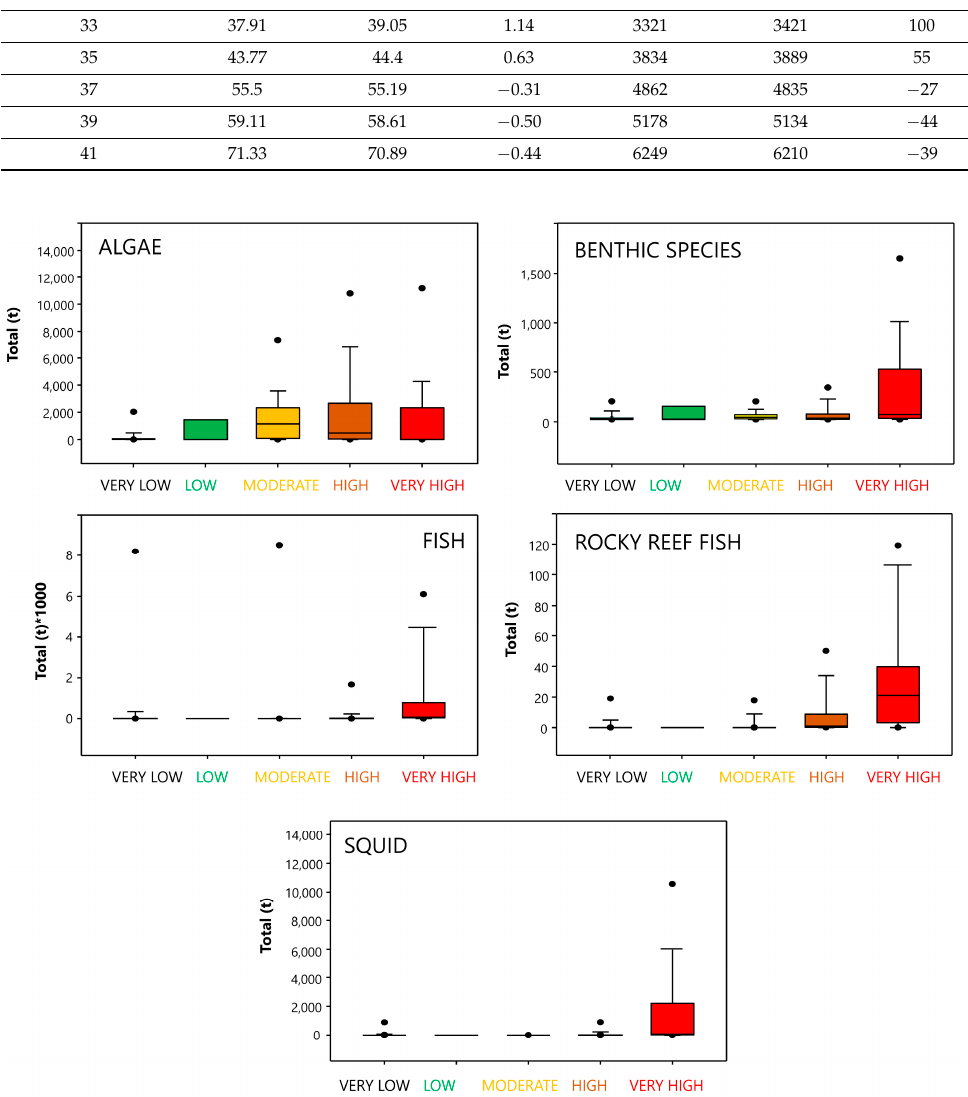
Figure 9. Fishery landings associated with fishing coves experiencing different levels of risk (very low, low, moderate, high, and very high) in the year 2017. Dots represent outliers, whiskers enclose 95% of the data, the interquartile range is depicted in colored bars and the median is shown with a black line.